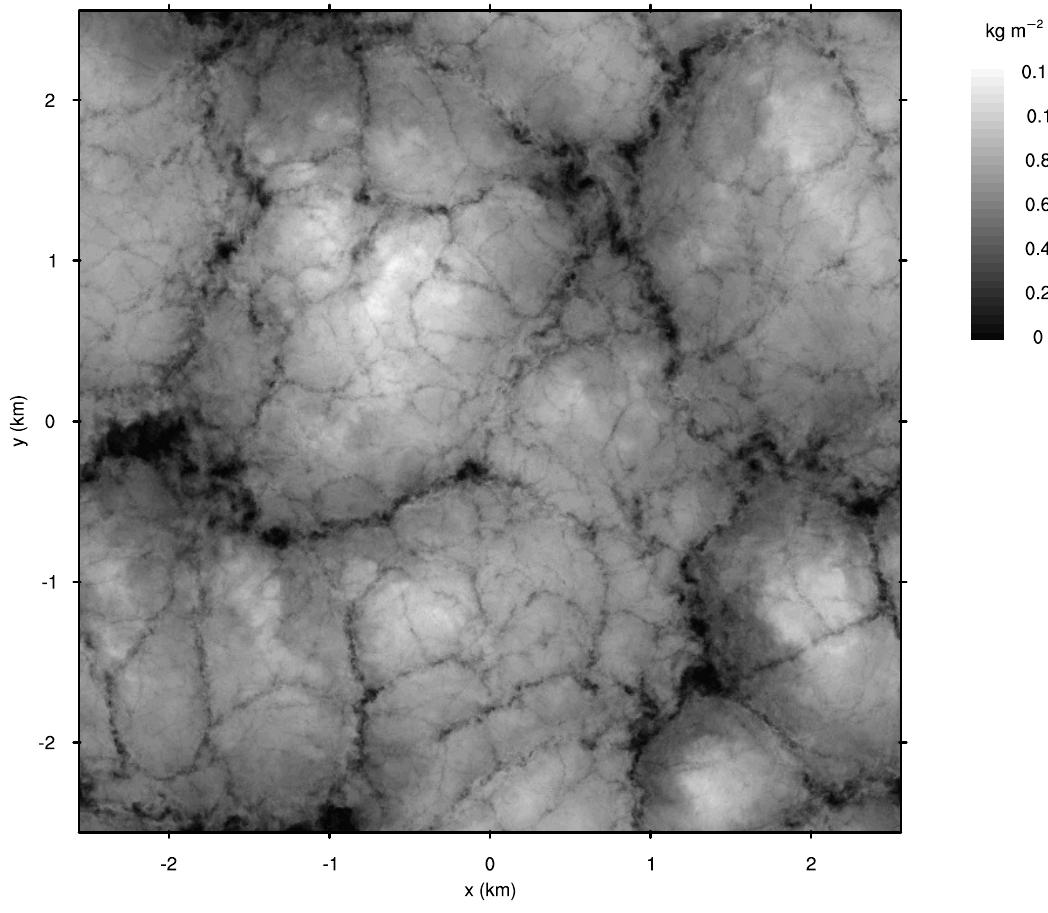
Figure 2. Cloud liquid water path.